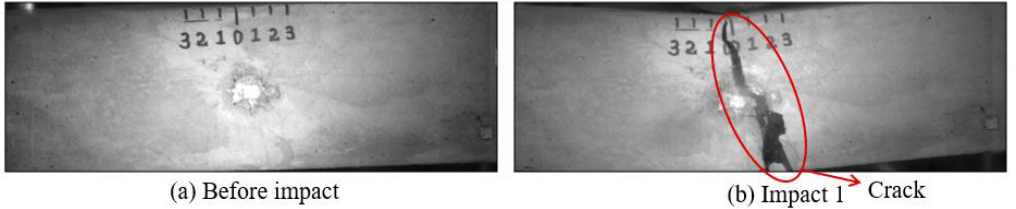
Figure 22 . Results of crack detection of Mortar-2 with high-speed video.